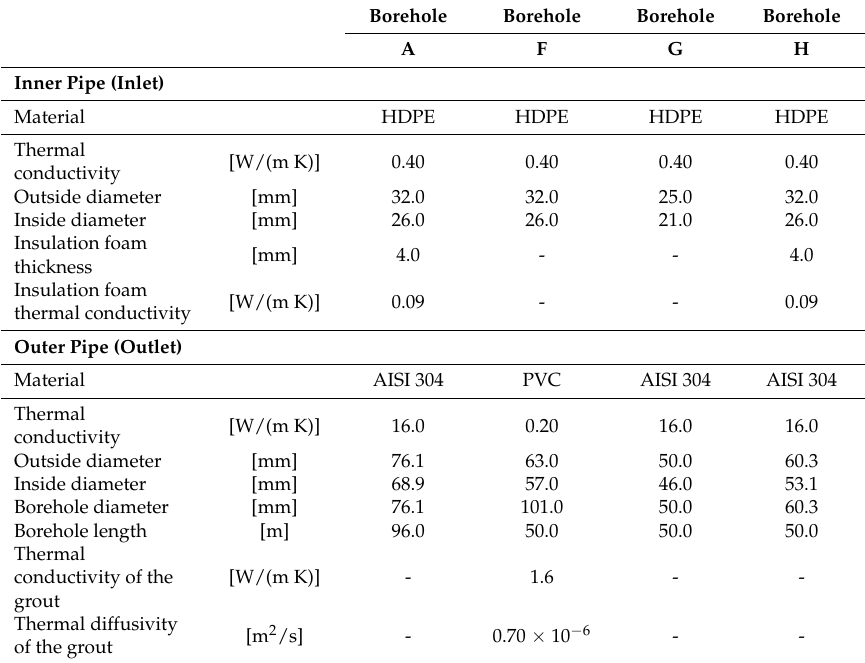
Table 2. Characteristics of the coaxial borehole heat exchangers.